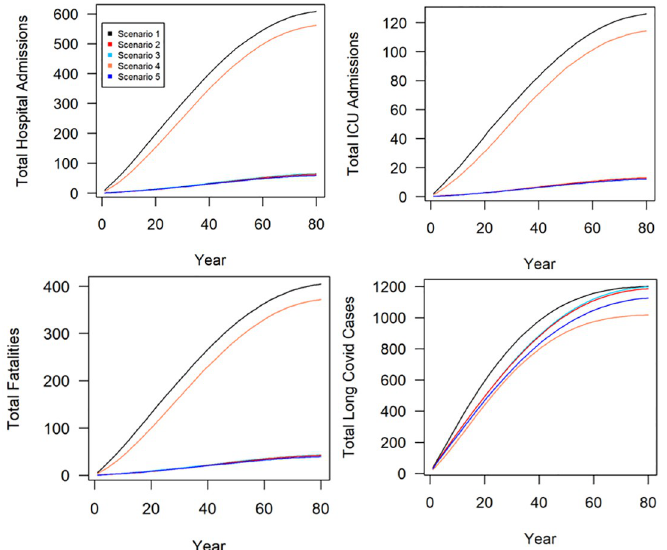
Fig 5. Results. Lifelong simulations of Covid-19 effects on total hospital admissions (a), total ICU admissions (b), total fatalities (c) and total Long Covid cases (d) following policy intervention scenarios. Scenario 1 is a baseline (no interventions); Scenario 2 is targeted vaccinations programme by age; Scenario 3 is targeted vaccinations by ‘clinically vulnerable’ risk group; Scenario 4 is periodic lockdowns; Scenario 5 is periodic lockdowns with whole population vaccination programme. Outputs represent the annual mean values of 100 simulation runs in a cohort of 1,000 agents.